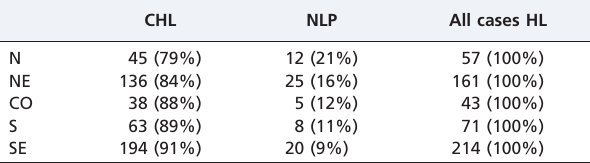
Figure 5 - Hodgkin lymphoma distribution. CHL: classic Hodgkin lymphoma; NLPHL: nodular lymphocyte predominant Hodgkin lymphoma. Table 6 - Geographic distribution of pediatric Hodgkin lymphoma.